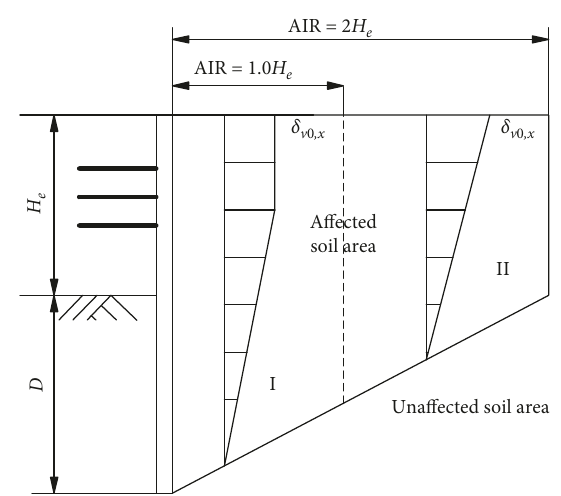
Figure 3: Apparent influence range (AIR) and regions of vertical soil displacement